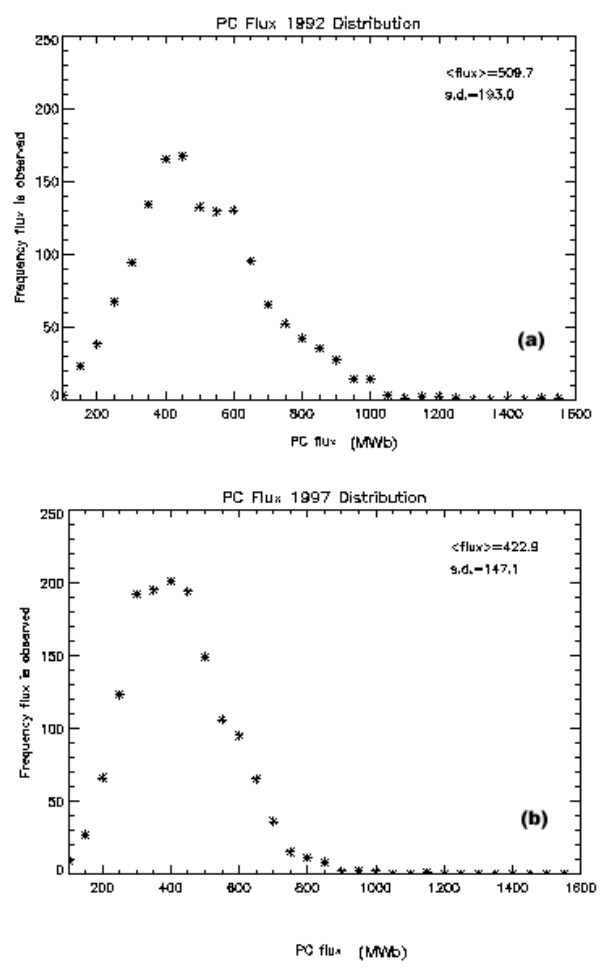
Fig. 3. Distributions of polar cap flux, 8 c , for (a) 1992 (an active year) and (b) 1997 (a quiet year). Notice the asymmetry, with a clear large-polar cap size